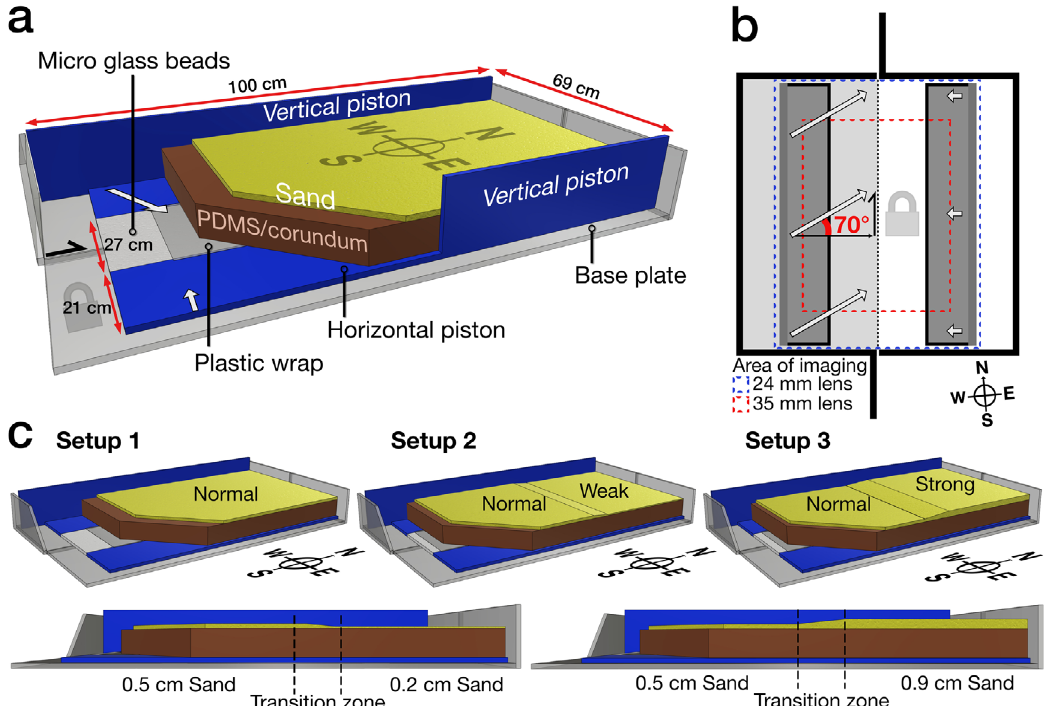
Fig. 3 Experimental setups and parameters of analogue experiments. a Sketch showing the general experimental setup. b Kinematic boundary conditions derived from the observed GPS velocity fi eld and used in the experiments. The sketch of the MultiBox and the corresponding kinematics have been mirrored to represent the kinematics of deformation in nature. c Schematic diagrams showing the three experimental